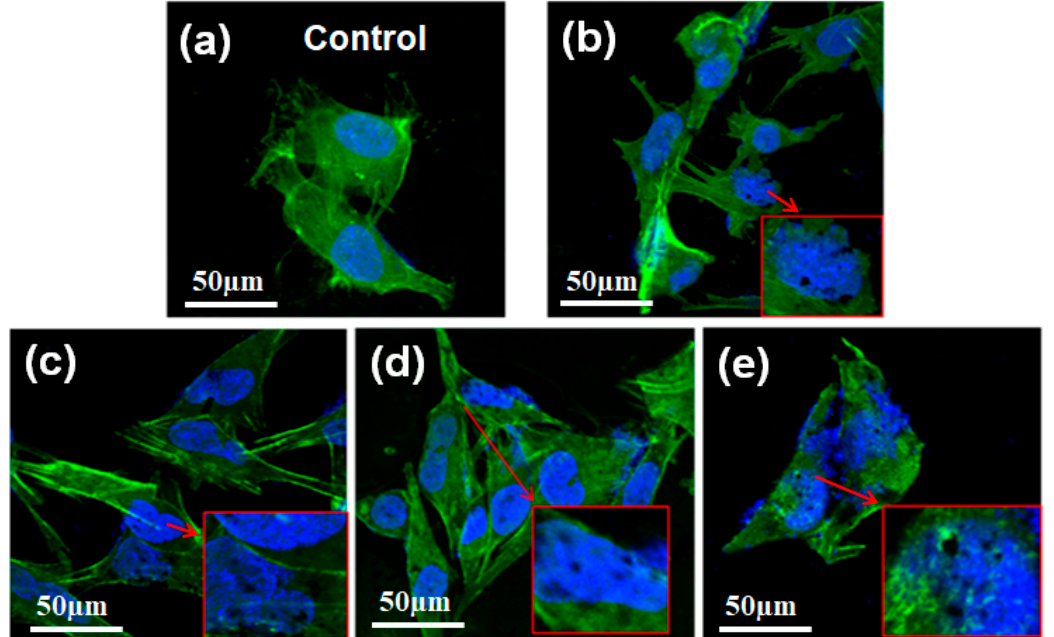
Figure 3. Confocal laser scanning microscopy images of OCM-1 cells marked by fluorescein isothiocyanate (FITC)-phalloidin and 4',6-diamidino-2-phenylindole (DAPI) after incubation with TG over various time periods: ( a ) The control, ( b ) 6 h, ( c ) 24 h, ( d ) 48 h, and ( e ) 72 h. The insets show the magnified images of the corresponding cell parts.